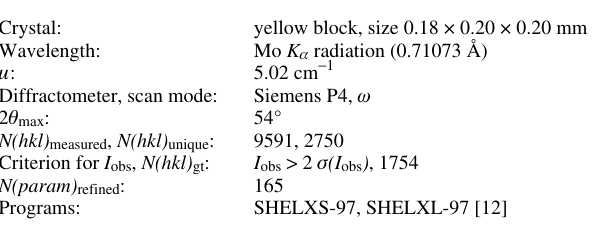
Table 1. Data collection and handling.